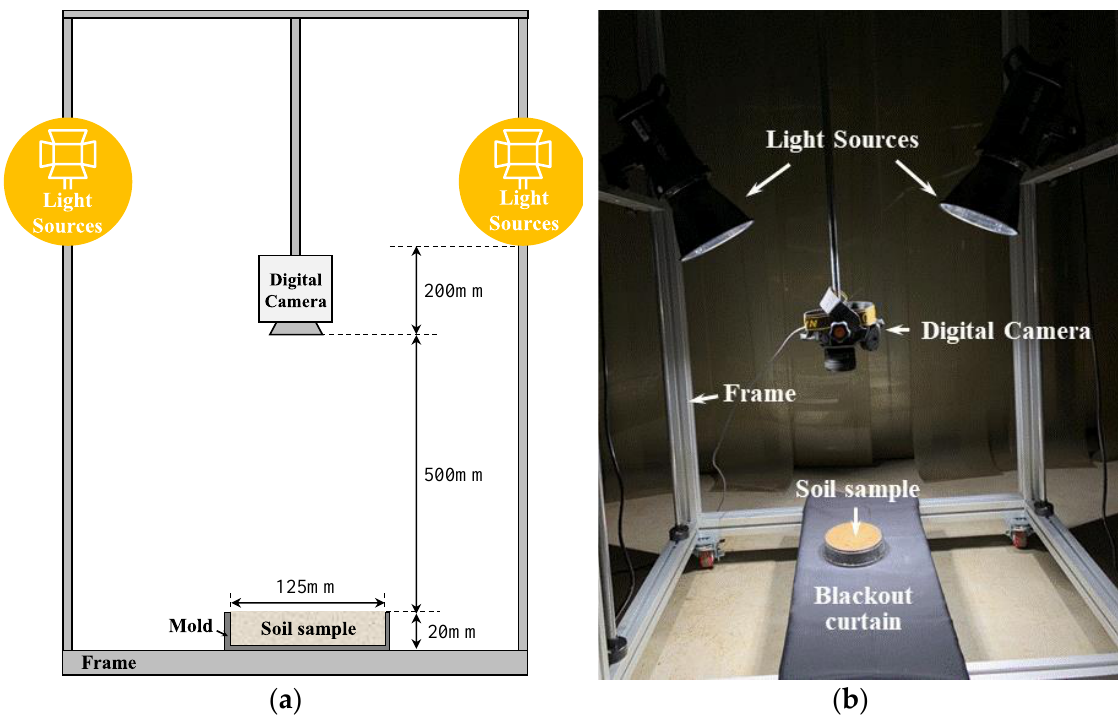
Figure 3. ( a ) Schematic diagram and ( b ) photograph of the digital image studio.